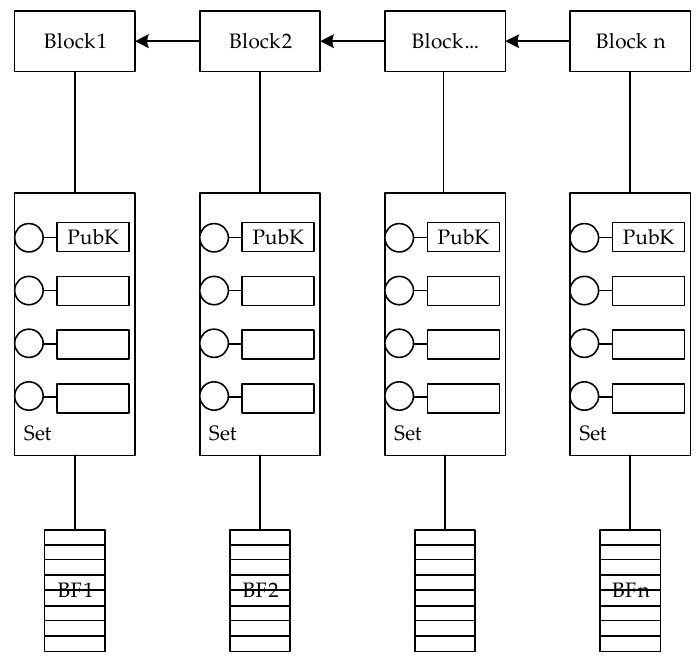
Figure 6. The data query scheme.